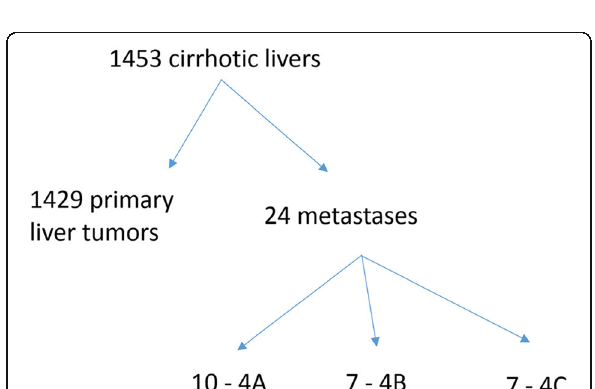
Fig. 3 Flowchart of metastases in cirrhotic livers by Laennec stage 4A, 4B and 4